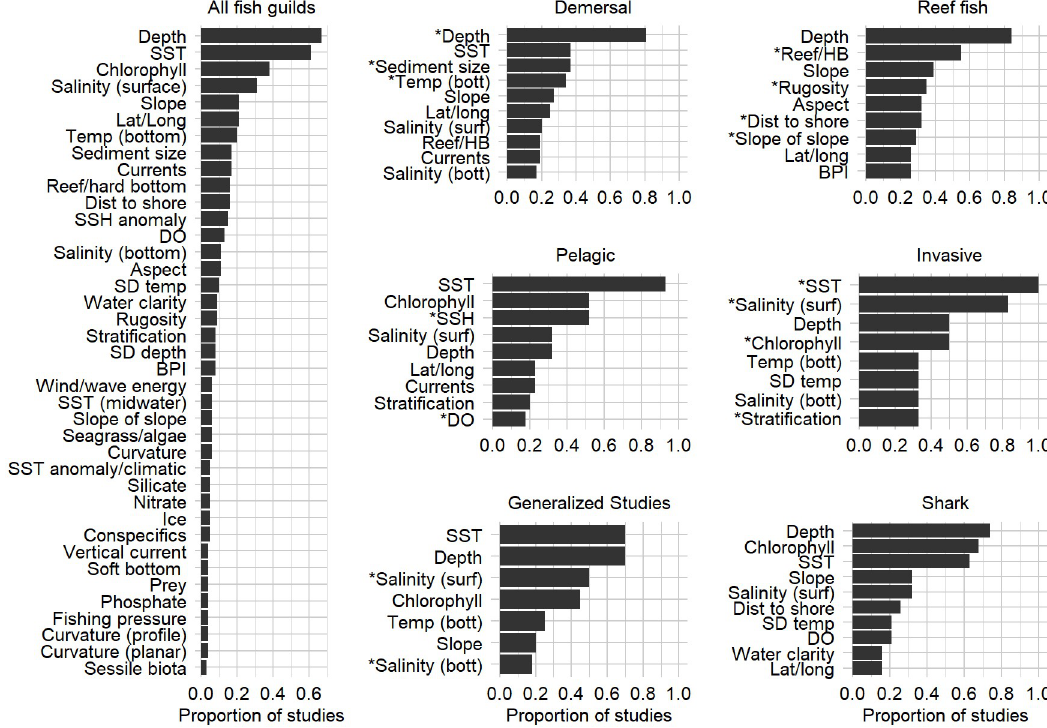
Fig 4. Frequency of predictor variables in marine fish spatial modeling articles. (Left panel) Frequency of predictors among all marine fish studies; variables in � 3% of studies are shown ( n = 224). (Right panel) The most frequent predictors within each fish guild; only predictors in > 15% of studies, or a maximum of 10 variables, are shown ( n = 224). � = predictor that distinguished the fish guild from others, as observed in Table 3; BPI = bathymetric position index, dist = distance, DO = dissolved oxygen, HB = hardbottom, Lat/Long = latitude/longitude coordinates, SD = standard deviation, SSH = sea surface height anomaly, SST = sea surface temperature, Temp = temperature, Bott = bottom, Suf = surface.